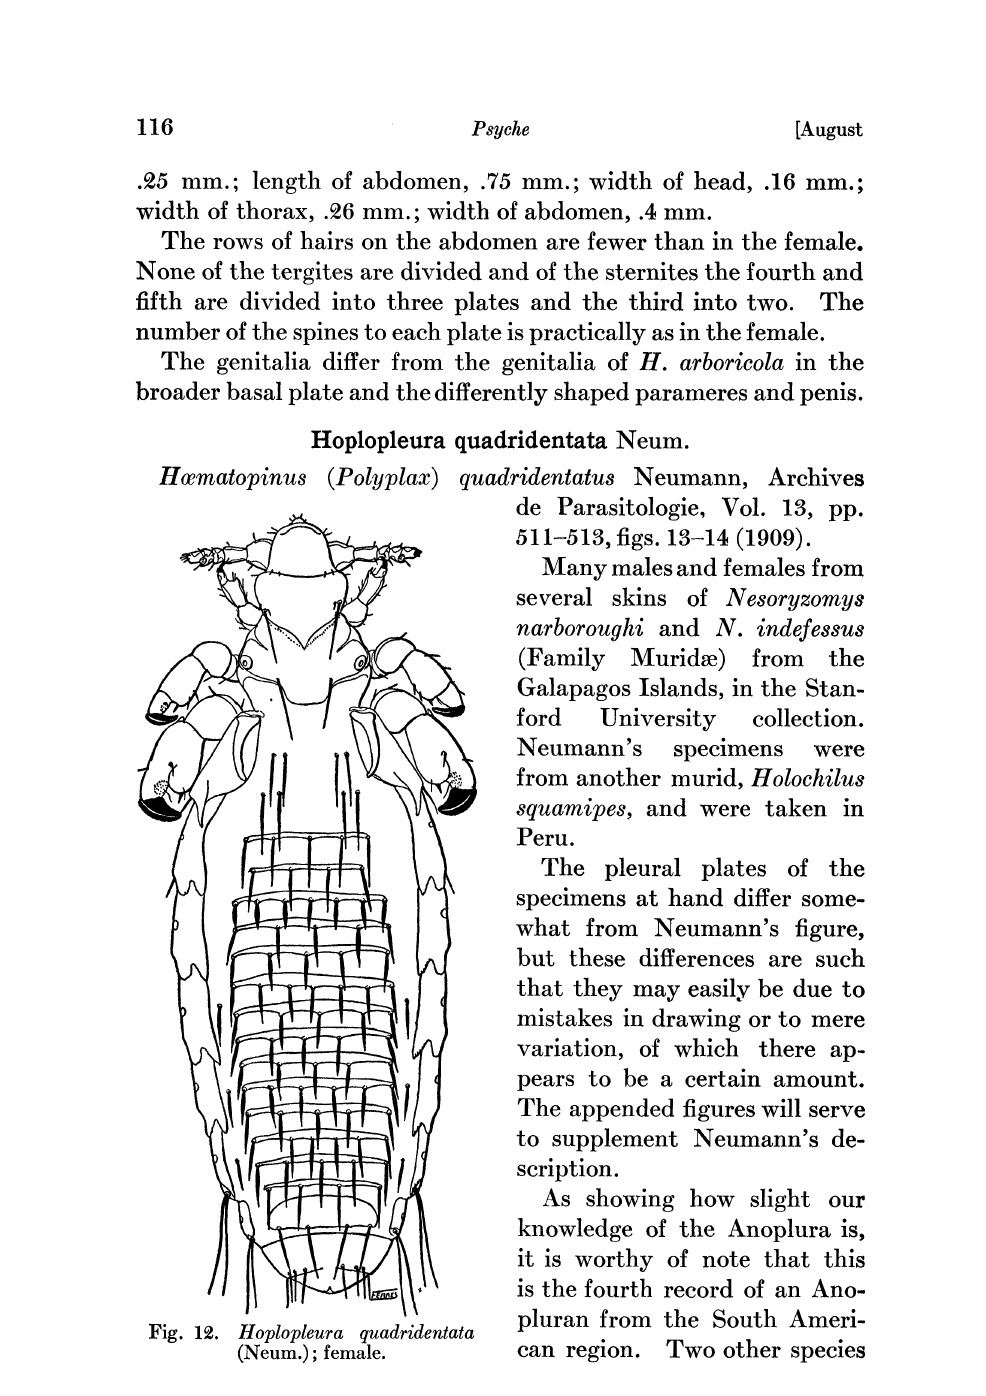
pluran from the South Ameri- Fig. 1. Hoplopleura quadridentata (Neum.); female, can region. Two other